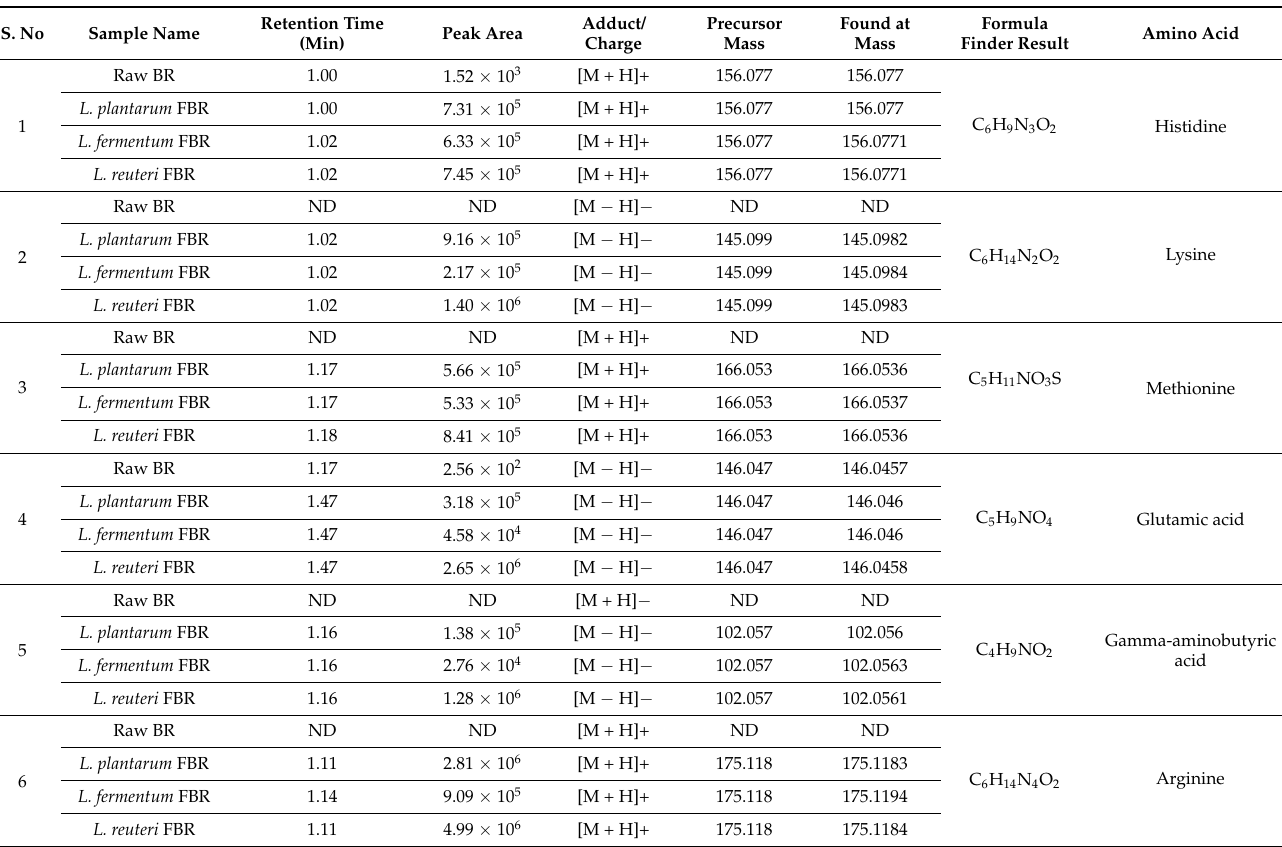
Figure 2. Heat map showing levels of amino acids in raw and different fermented BR samples. Table 3. Amino acids detected in raw and LABs fermented brown